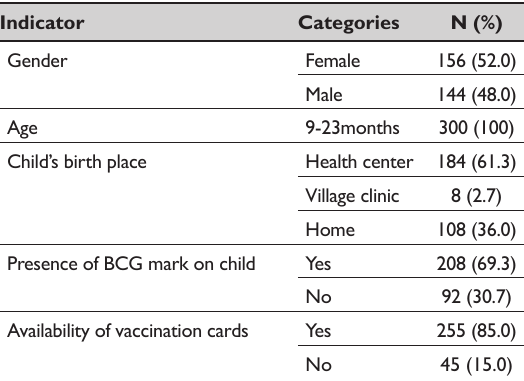
Table 2: Characteristics of children enrolled